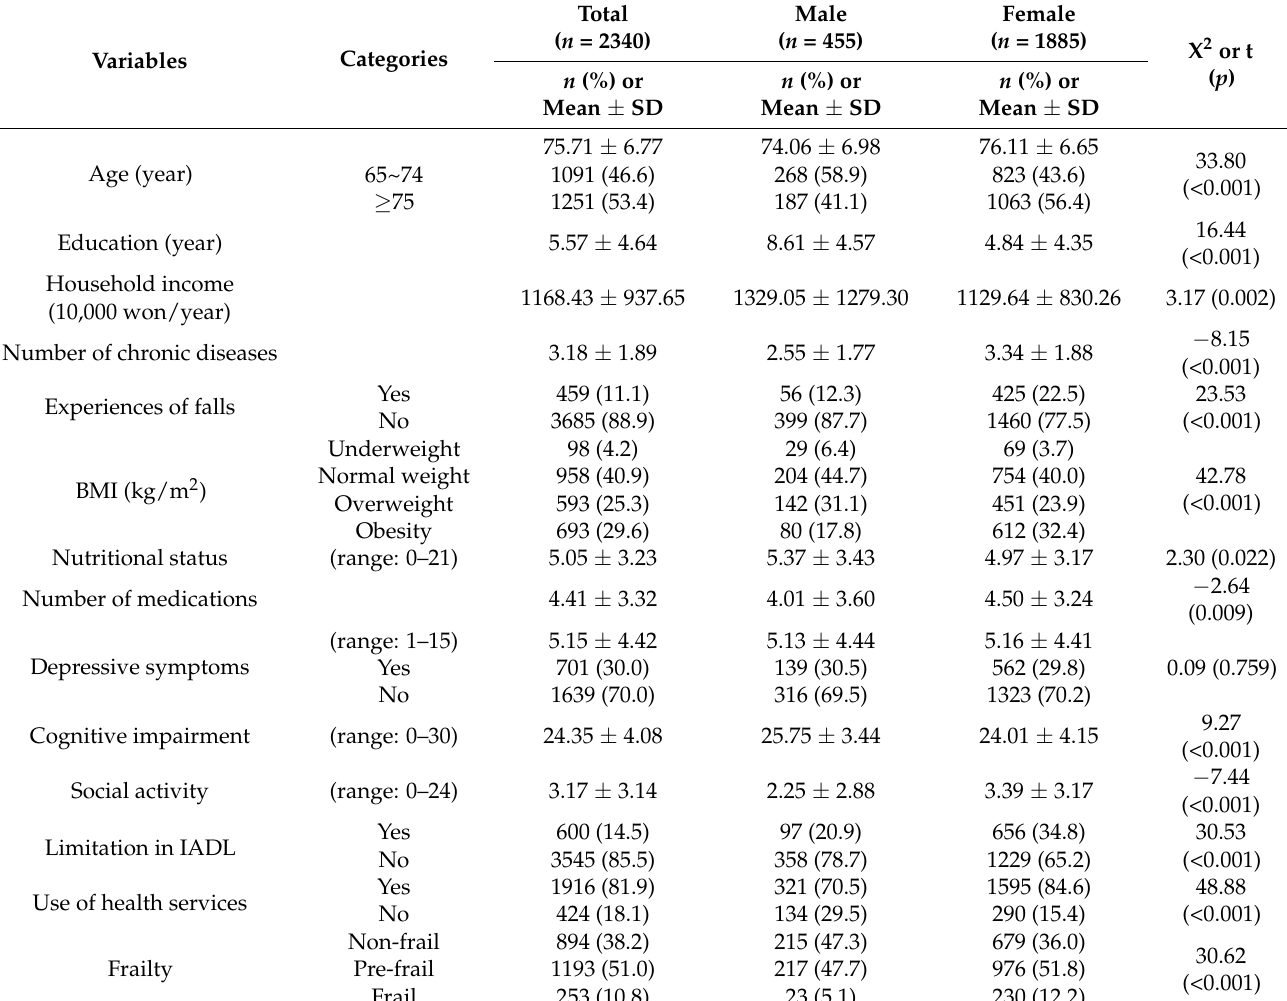
Table 1. General Characteristics of Participants by Gender. n =